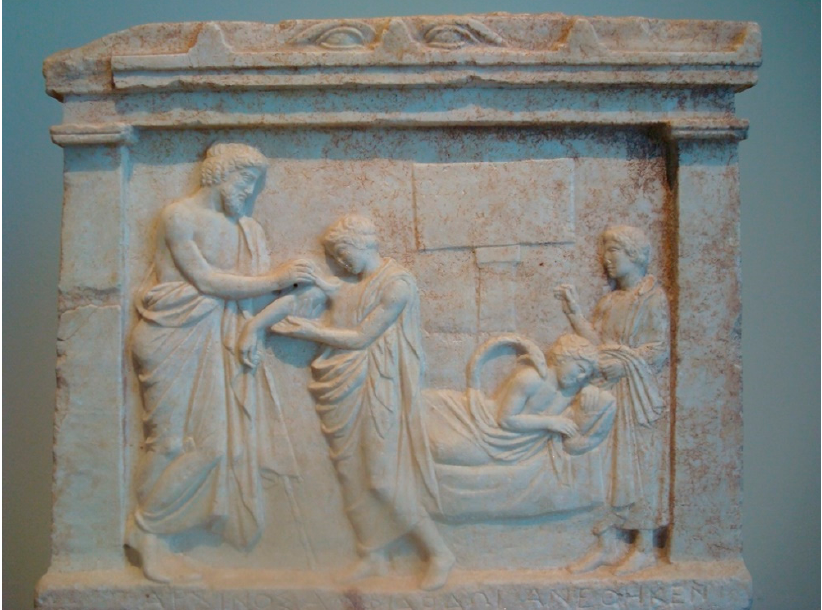
Figure 12. Archinos relief from the Amphiareion at Oropos (NAM inv. no. 3369); marble; Attica; ca. 400–380 BCE . [Photo by the author].